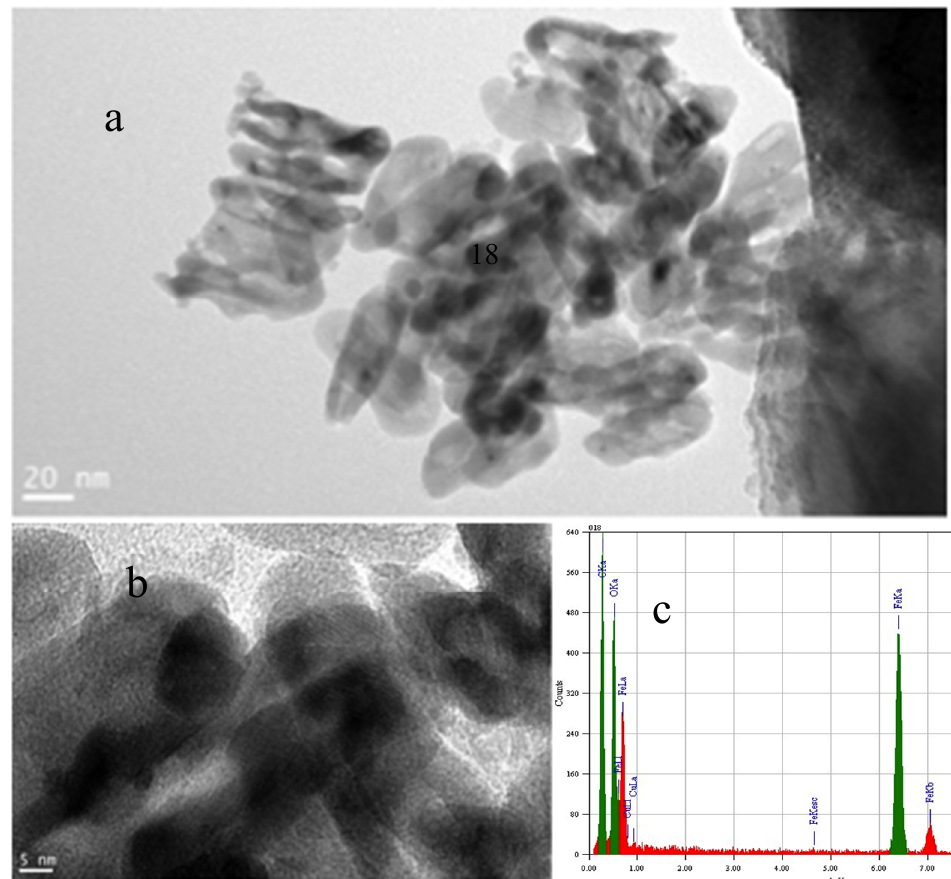
Figure 5. ( a ) shows a TEM image of the surface of biochar after cycling; ( b ) is a higher resolution image of the area shown in ( a ) (18) and ( c ) is an EDS spectrum from area 18 in ( a